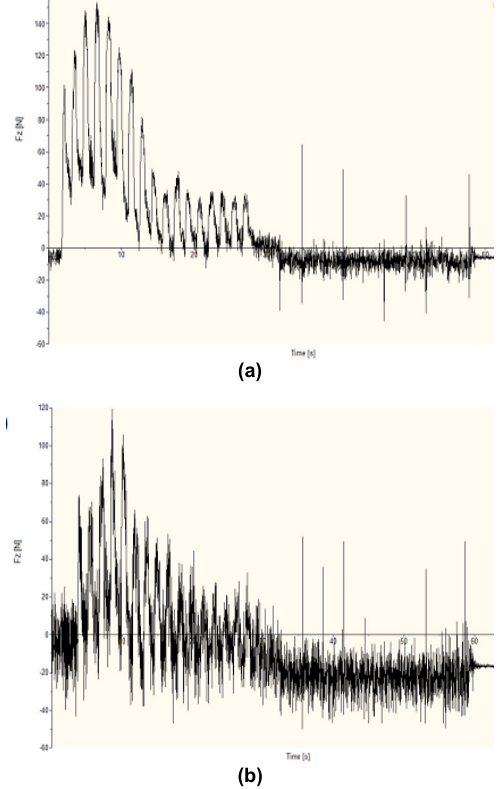
Figure 8. Variation of thrust force with drilling time in UAD for SiC content of: (a) 1%wt and (b) 2 %wt. (spindle speed= 1100 rpm and feed rate= 20 mm/min).